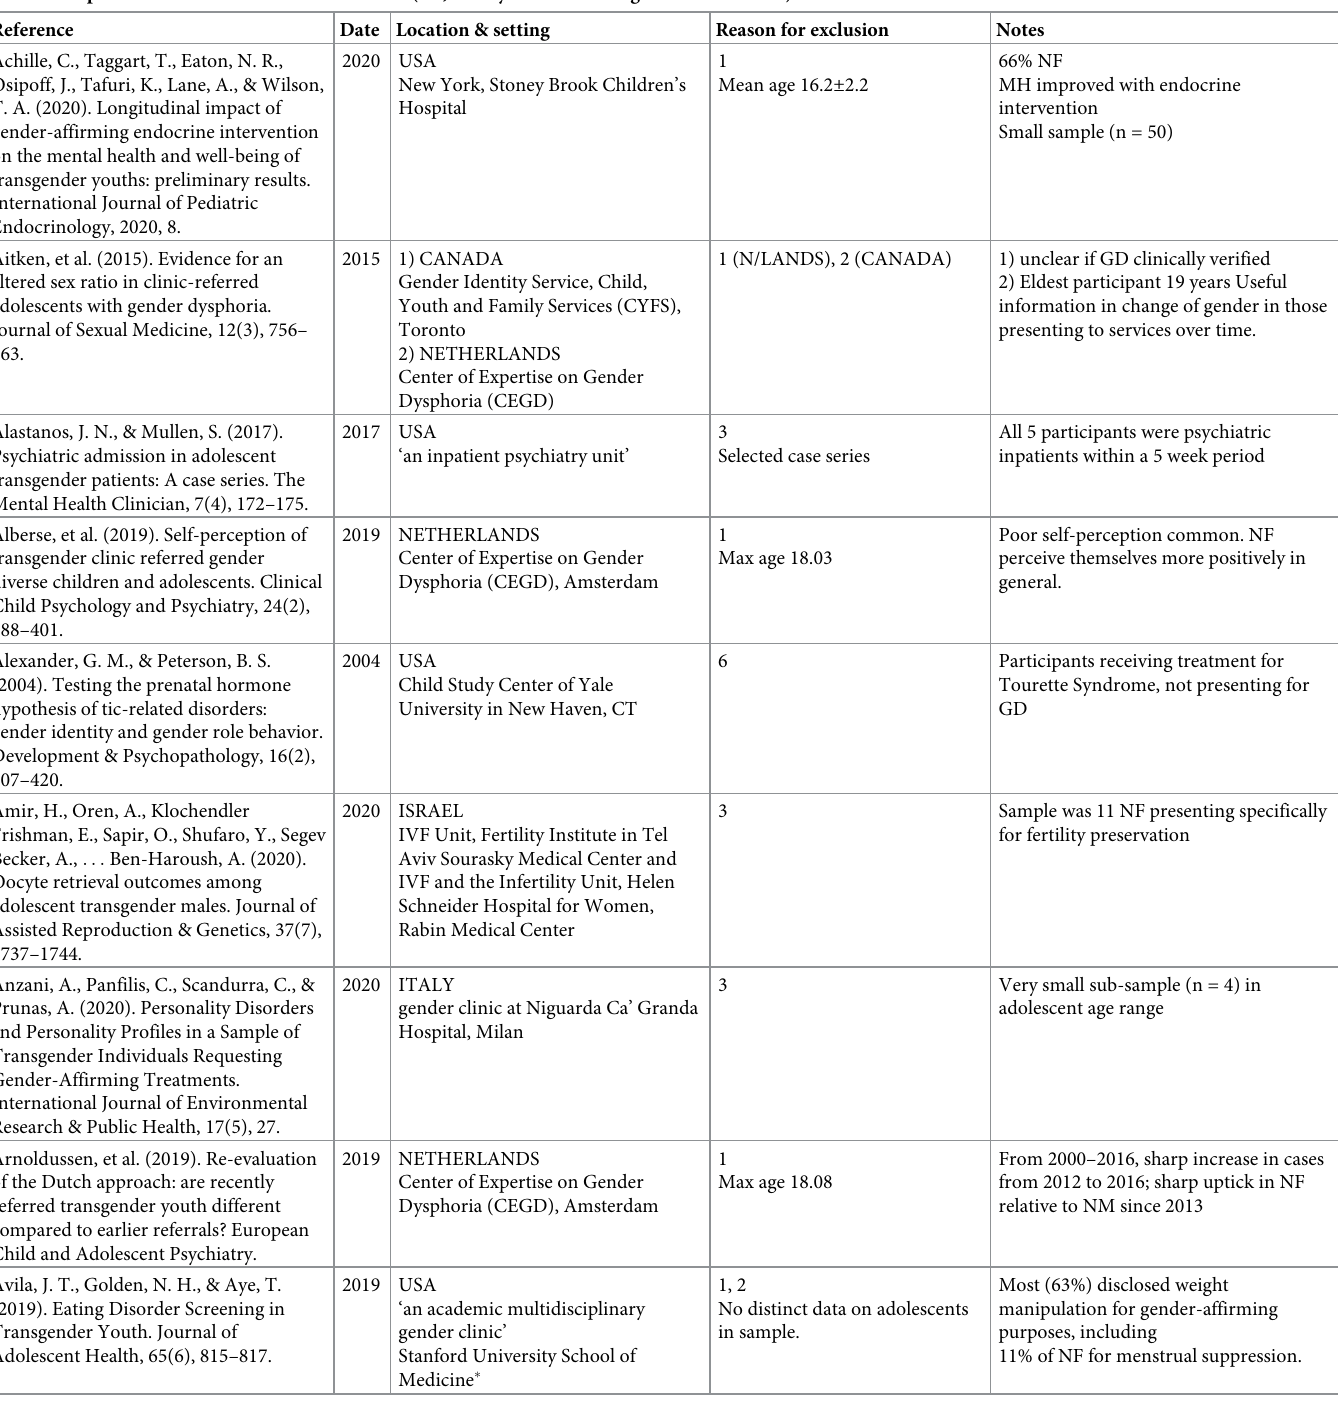
Table 5. Papers excluded at second full text screen (i.e., closely missed meeting inclusion